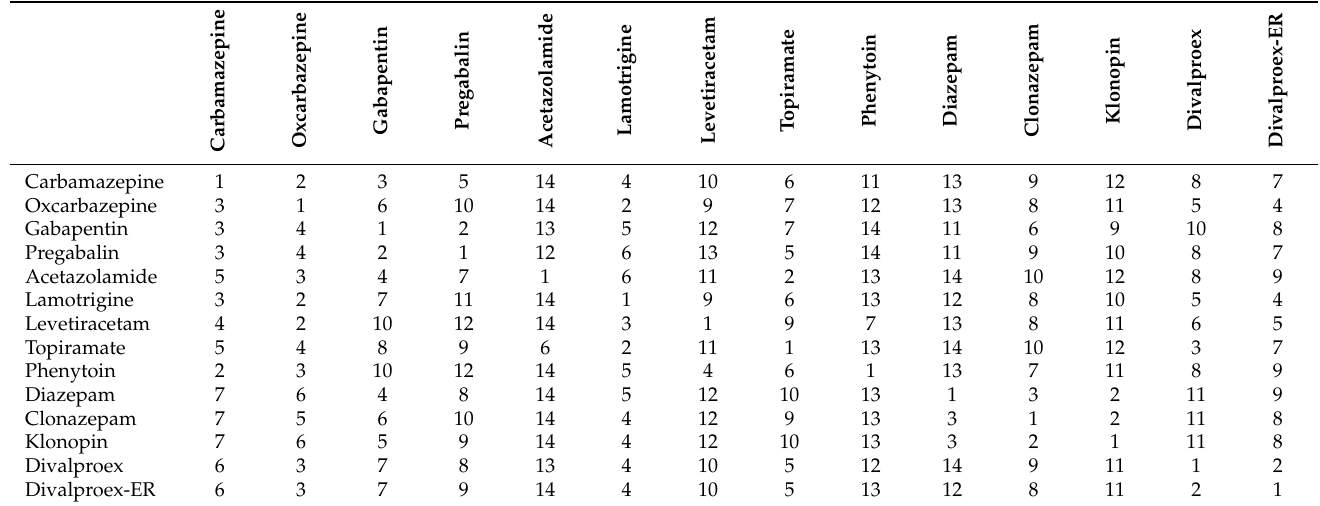
Table 6. AEDs Drug-Drug Similarity-based Rankings using CS Measure.